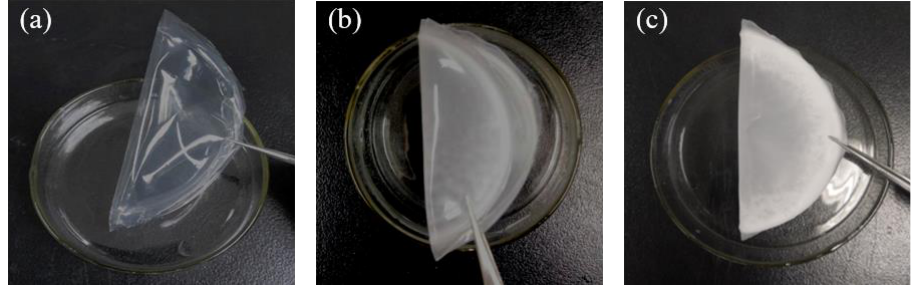
Figure 1. Macroscopic morphologies of the ( a ) SPE-Zn membrane, ( b ) ILPE-Zn-4 membrane, and ( c ) ILPE-Zn-5 membrane. and ( c ) ILPE-Zn-5